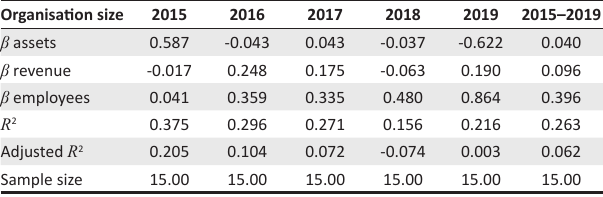
TABLE 1: Multiple regression – Organisation size on chief executive officers’ fixed